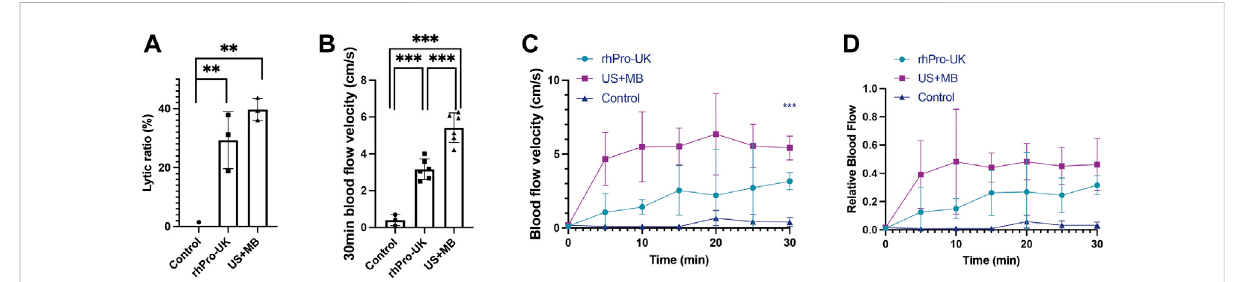
FIGURE 2 Microbubble enhanced endovascular LFUS sonothrombolysis. (A) Lytic ratio in vitro . (B) The 30-min blood fl ow velocity in vivo . (C) Blood fl ow velocity curves in 30 min treatment in vivo. (D) Relative blood fl ow compared to baseline in 30 min treatment in vivo (*** p < 0.001, ** p < 0.01).